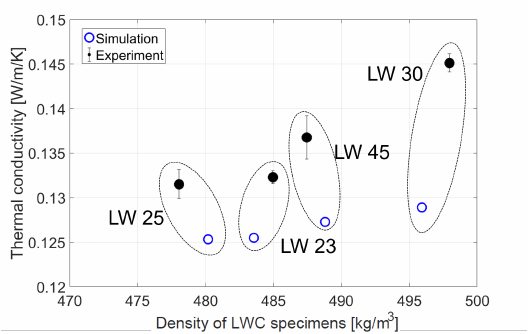
Figure 7. Comparison of thermal conductivities of the LWC samples.